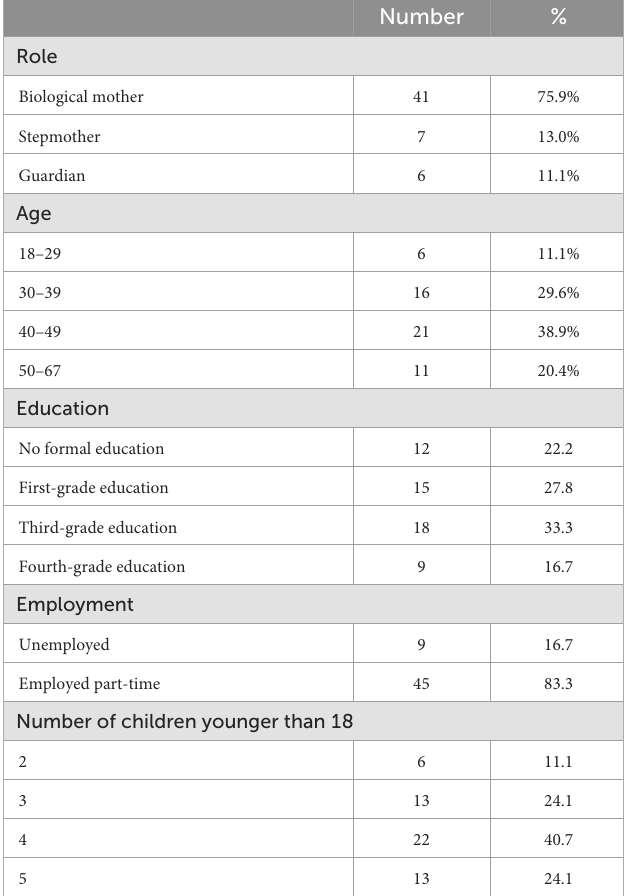
TABLE 2 Characteristics of mothers participating in the five focus groups during step 1, n =